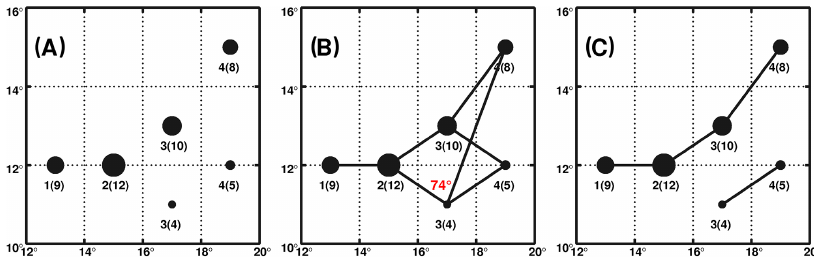
Figure 3. (a) An idealized case of cyclone locations in four time steps. The locations are depicted by circles. The numbers above the locations are in the form X(Y) , where X denotes the time step and Y denotes the relative vorticity. The circle sizes are proportional to the relative vorticity value of the cyclone. (b) All possible trajectories of cyclone 2(12) by searching backward and forward in time. (c) A selected subset of tracks of (b) : we retain those which present the minimum average change of relative vorticity in successive time